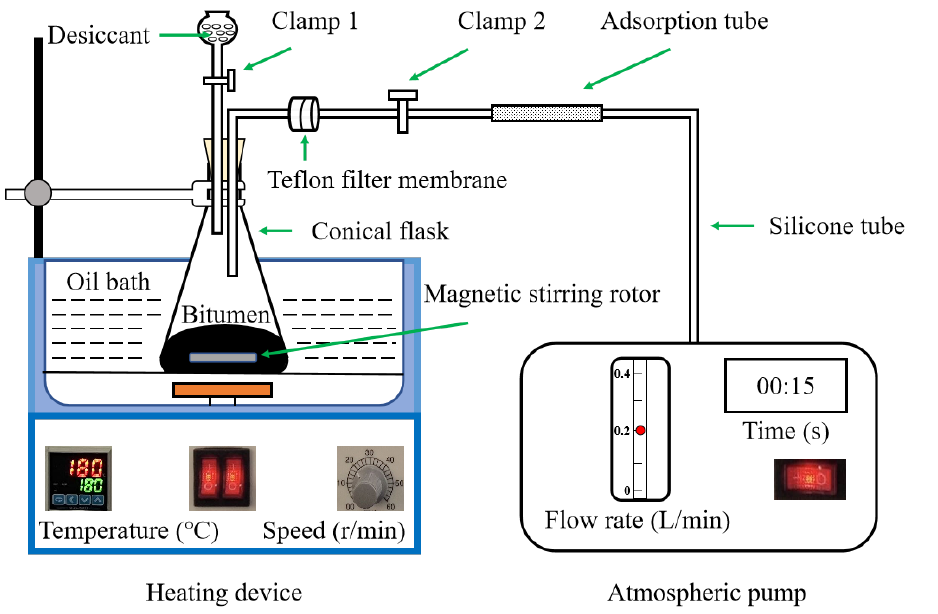
Figure 1. VOCs sample collection device.